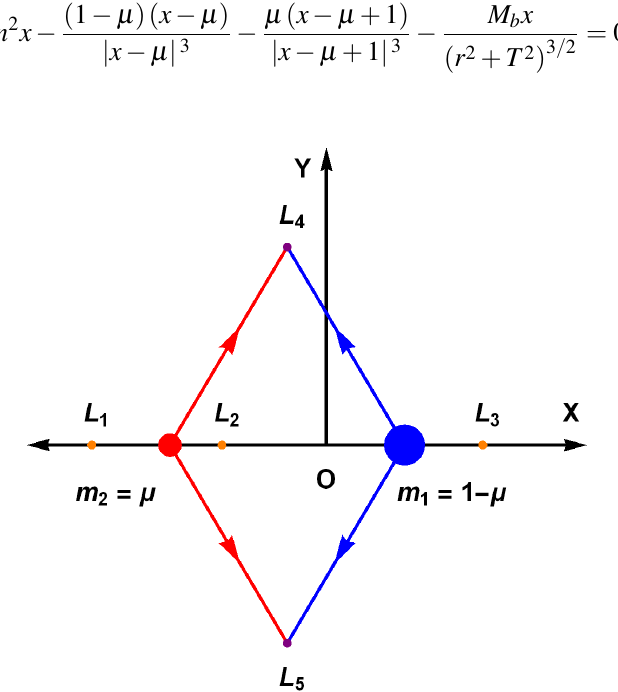
Fig. 2 Configuration of equilibrium points (Color figure